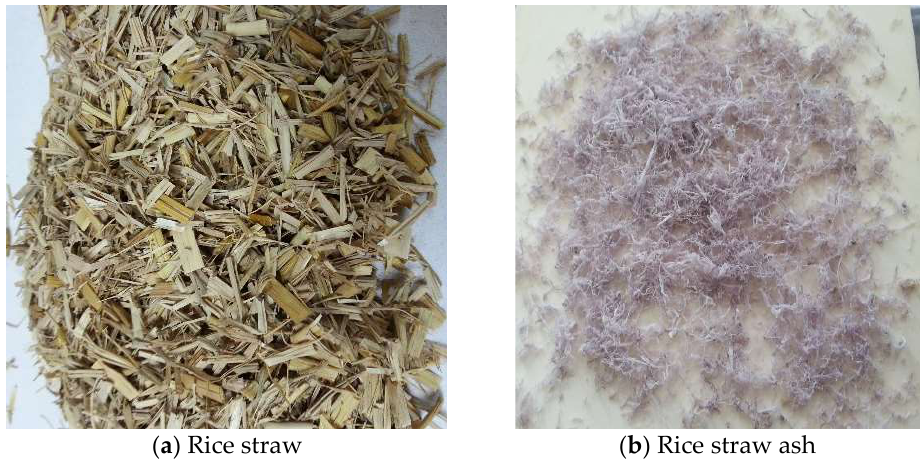
Figure 6. ( a ) Rice straw and ( b ) rice straw ash after firing at 950 °C.